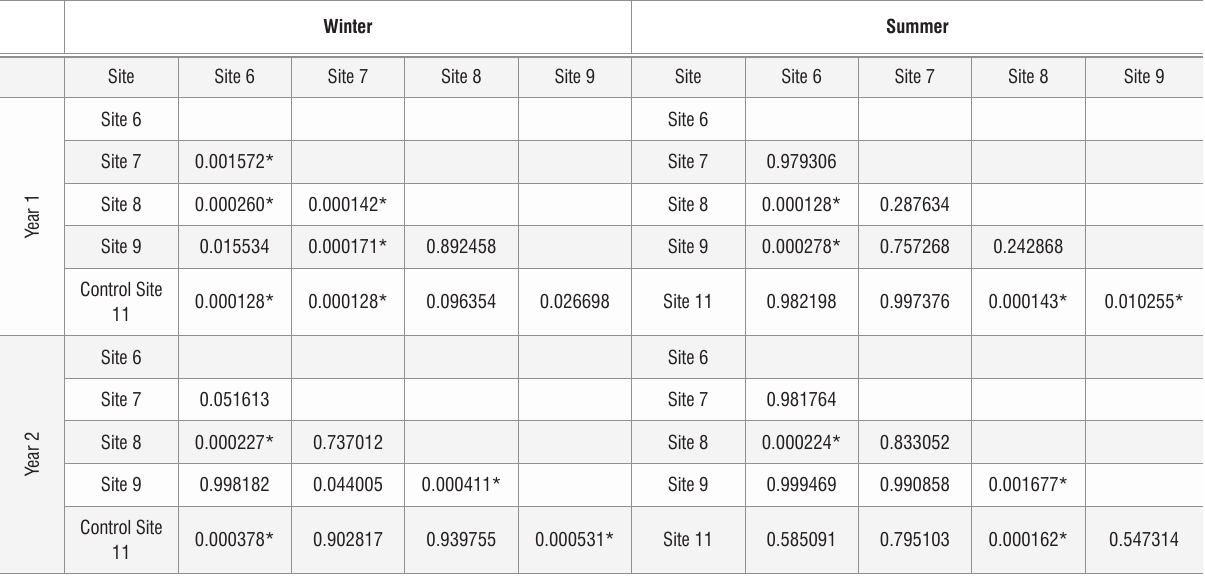
One-way analysis of variance (Tukey’s honest significant difference test) results of comparisons between red edge position values at sites affected by acid mine drainage and that of an unaffected control site, in winter and summer over 2 years